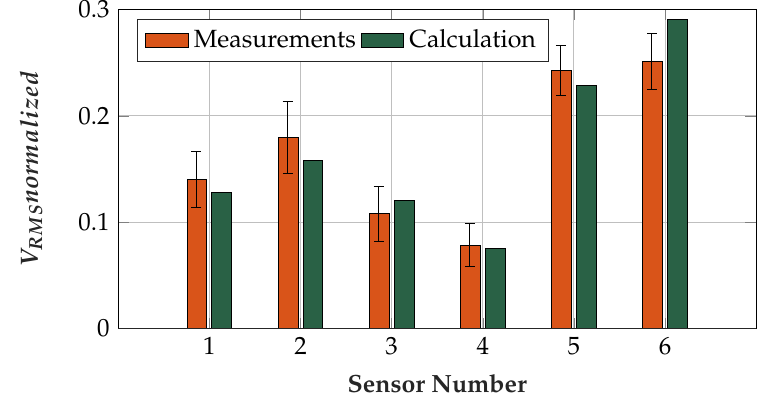
Figure 17. Normalized measured mean V RMS values (including standard deviations) and normalized calculated V RMS values for comparing the coupling characteristics of different sensor assemblies.